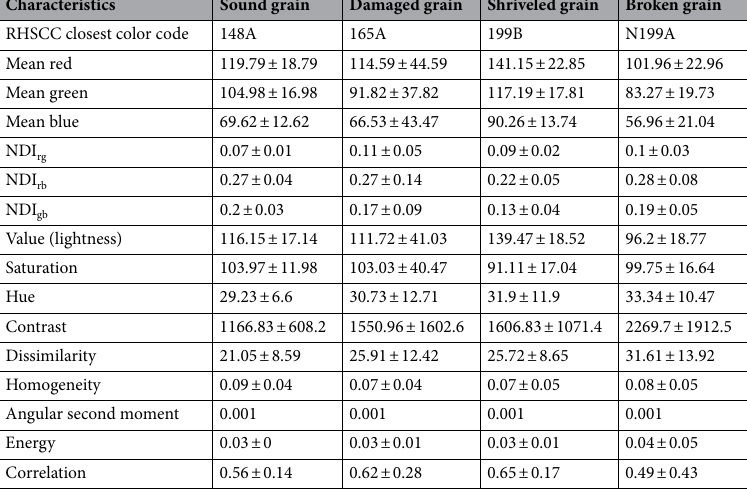
Table 8. Color and texture parameters derived from image of selected wheat